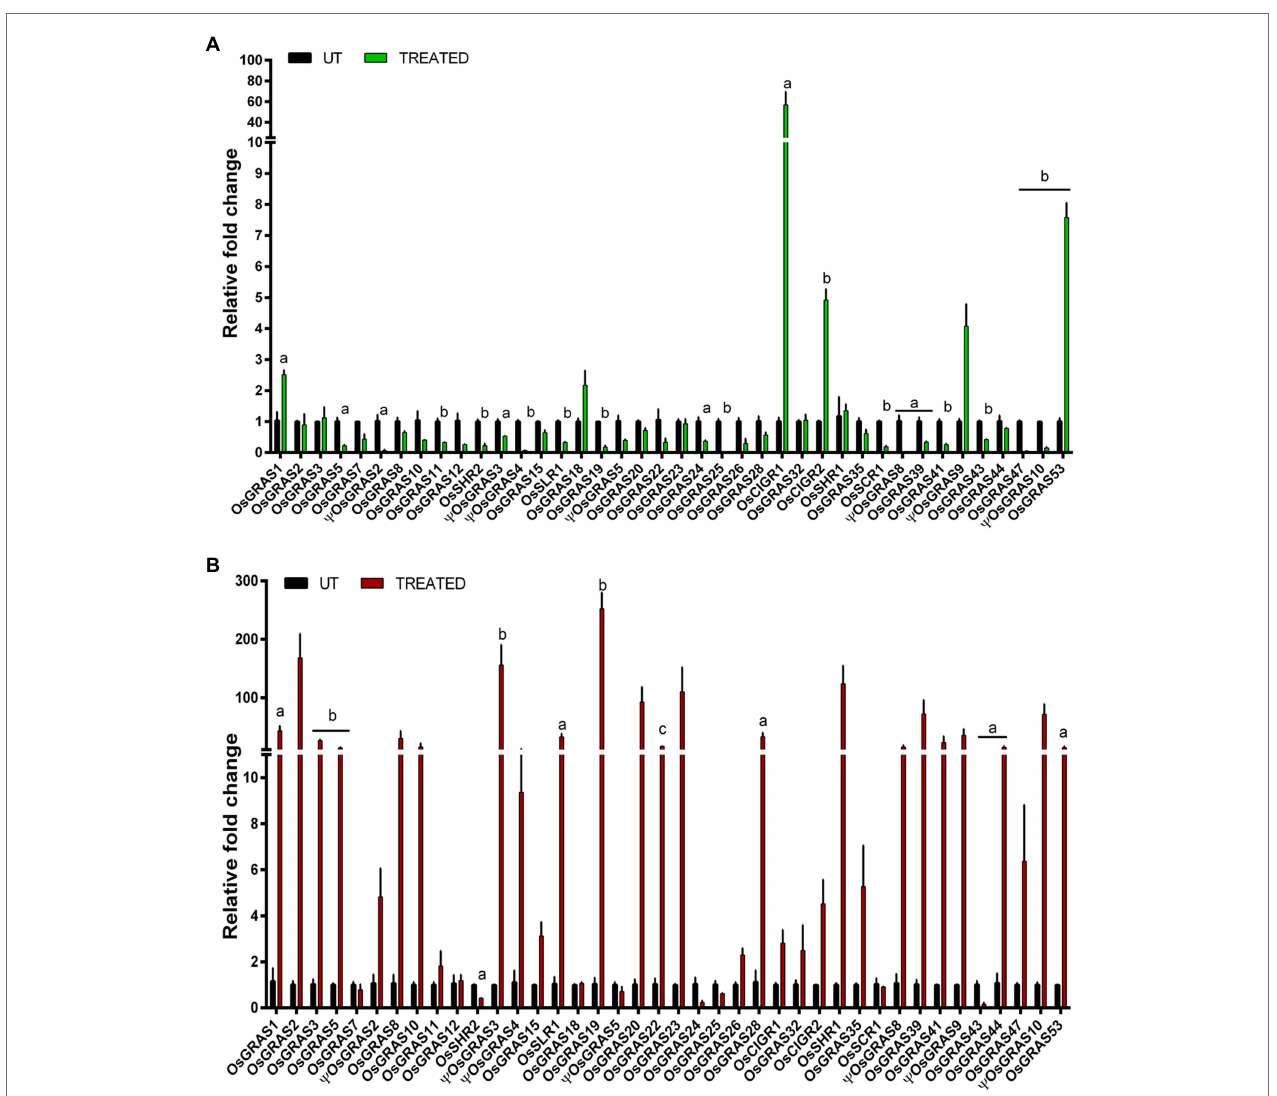
FIGURE 6 | Quantitative real-time expression analysis of GRAS genes under biotic stress. Expression analysis of GRAS genes under the infection of Xanthomonas oryzae pv. oryzae causing bacterial leaf blight (A) and Rhizoctonia solani causing sheath blight (B) were studied. The genes were double normalized using rice actin and tubulin as internal reference genes and the C T values of untreated samples by ΔΔ C T method. The experiment was conducted using biological and technical triplicates ( n = 3) and a one way ANOVA was performed on the data using SigmaPlot v. 11 to gauge their statistical significane. a represents p < 0.05, b represents p < 0.025 and c represents p < 0.001. The data represent mean ±